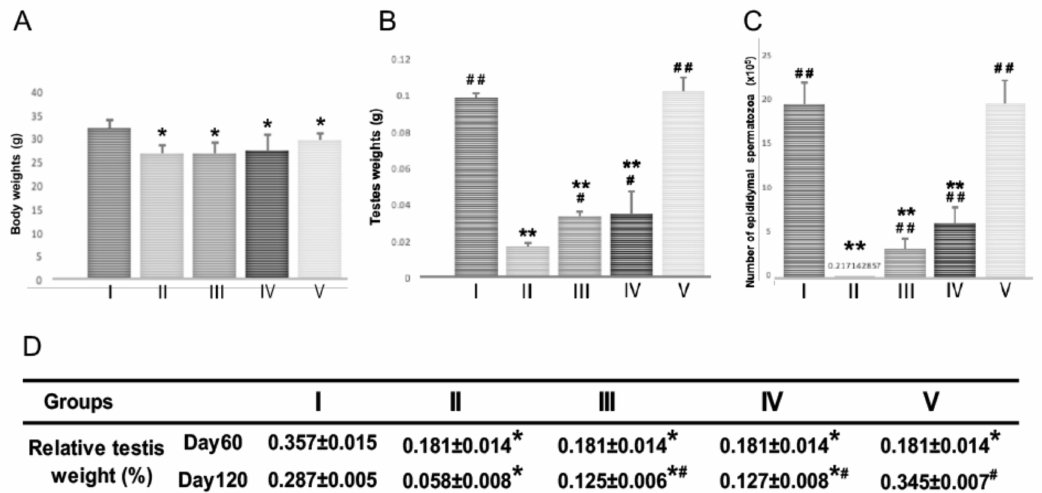
Figure 2. Body weight, testis weight, and sperm count after BSF treatment followed by diet supplementation with Hachimi-jio-gan and / or Hochu-ekki-to. ( A ) Body weight, ( B ) Testis weight, and ( C ) Epididymal spermatozoa count of mice in each group at Day 120. ( D ) Relative testis weight in each group at Day 60 and Day 120. Relative testis weight was calculated in percentage by dividing the combined weight of both testes in milligrams by body weight in grams. Data have been presented as mean ± standard deviation. * p < 0.05 and ** p < 0.01 vs. the control group; # p < 0.05 and ## p < 0.01 vs. the BSF